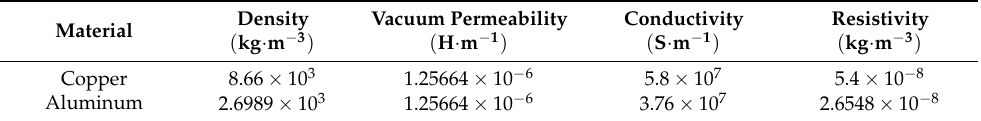
Table 1. Material parameter setting.